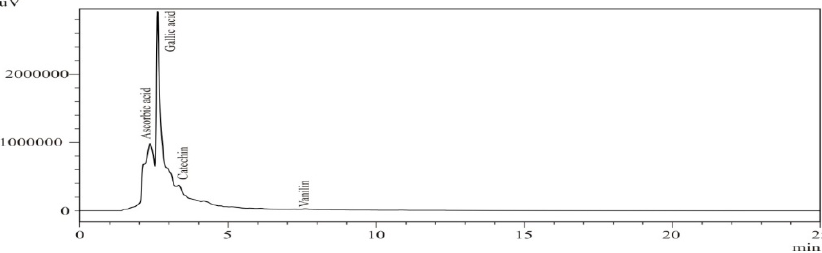
Figure 1. Phenolic acid composition of un-fermented rice bran at 280 nm.